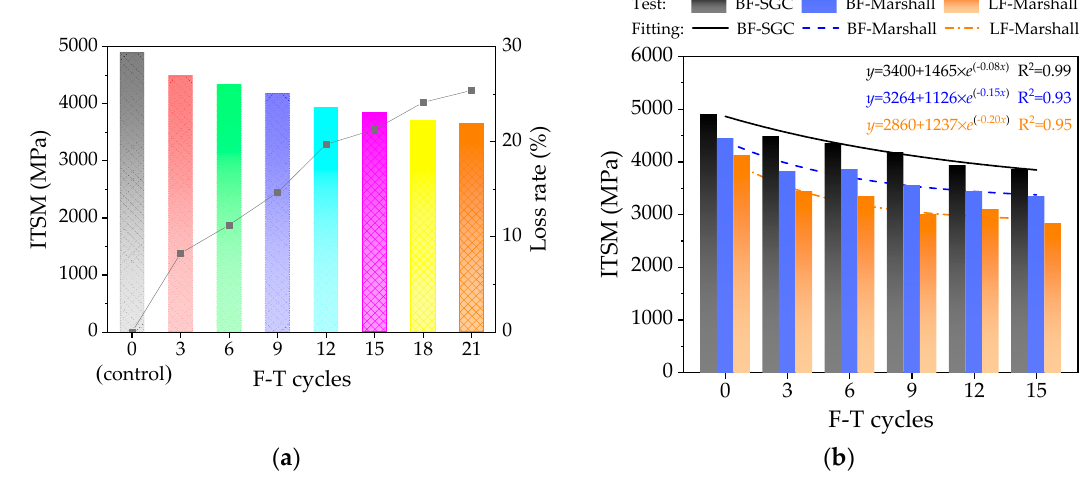
Figure 8. The ITSM results: ( a ) ITSM, ( b ) comparative results.